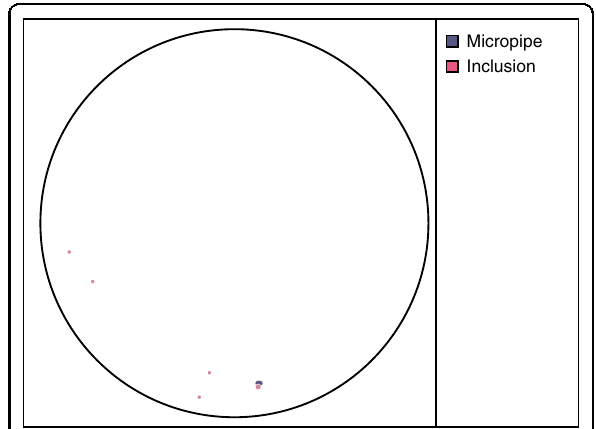
Fig. 3 The micropipe distribution of 6-inch n-type SiC substrate (only one micropipe)